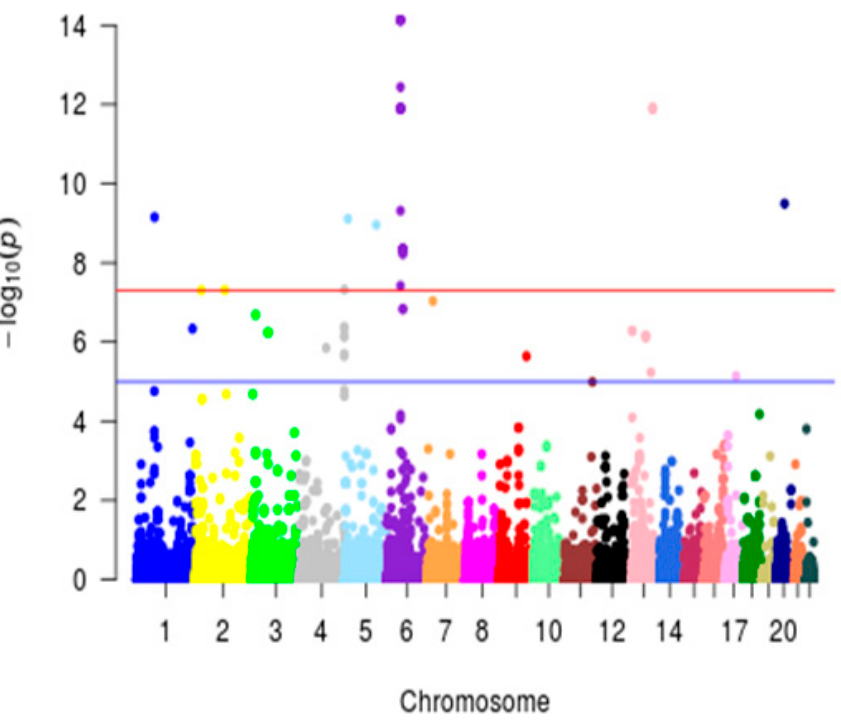
Figure 2. Manhattan plot illustrating the polygenic control of metabolic features. Genome-wide association study was carried out with over 2.5 M imputed SNPs, for the metabolomic feature characterized by a mass-to-charge ratio of 227.216 and a retention time of 67.49. Chromosomes are color-coded. Evidence of significant associations (LOD >8) with this metabolic feature were found on chromosomes 1, 5, 6, 13 and 20. The Y -axis corresponds to the significance of the association ( − Log10 p -values). The X -axis represents the physical location of the variant colored by